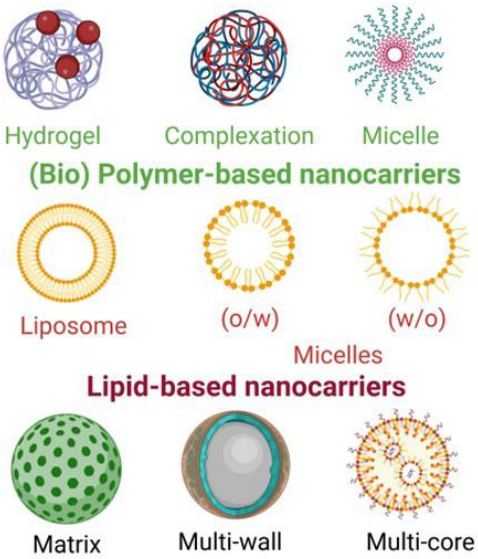
Figure 3. Some important nanocarriers for bioactive compounds used in food applications (created with BioRender.com, accessed on 4 December